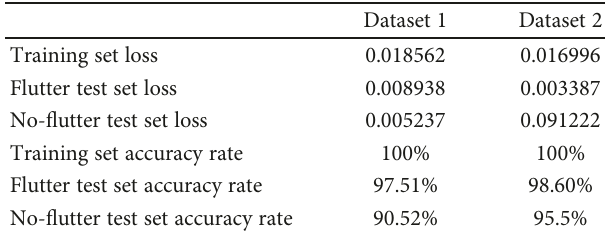
Table 3: Model validation.